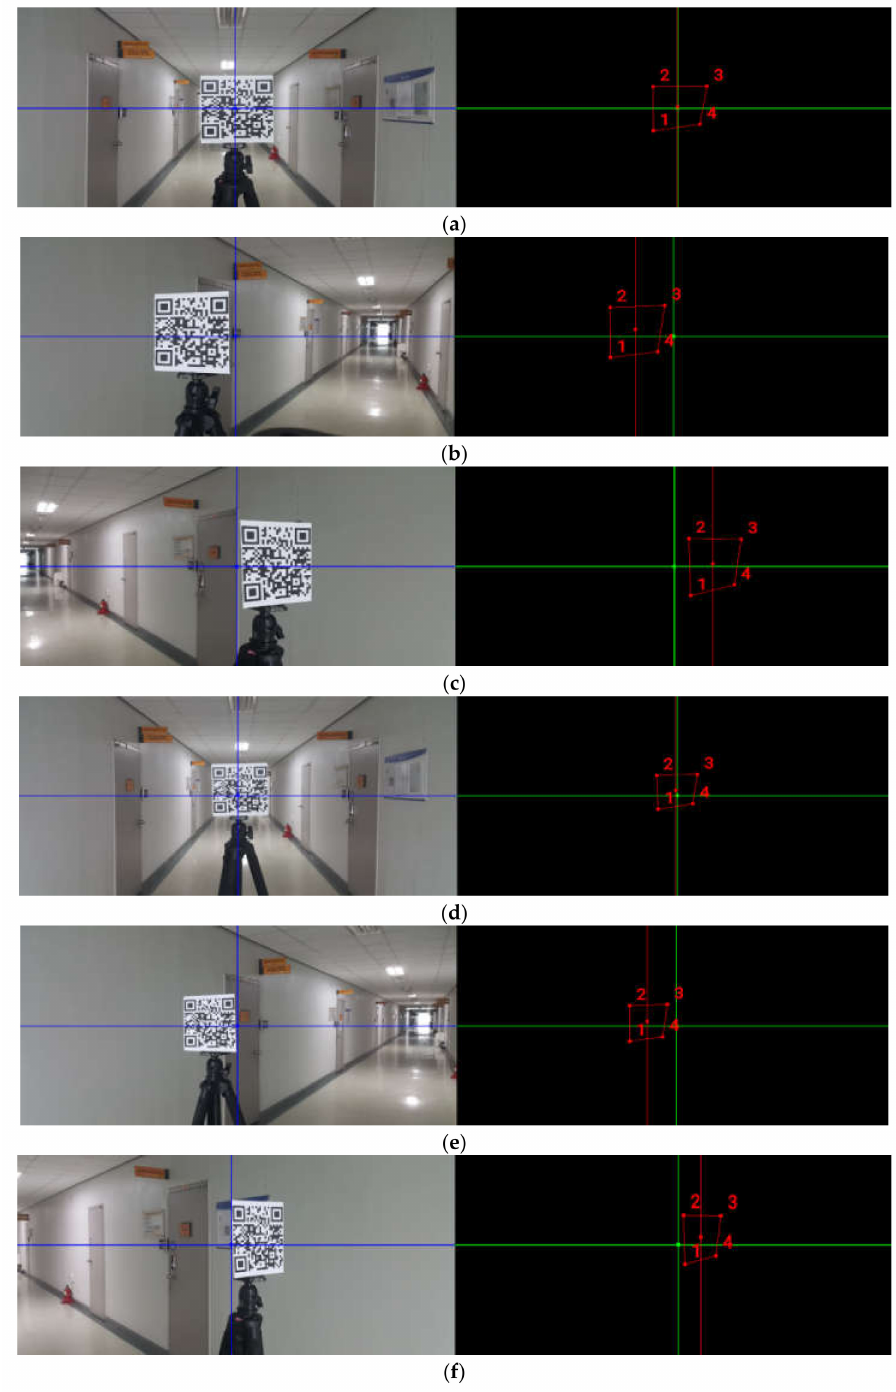
Figure 5. Pictures taken from the ( a ) front, ( b ) left, and ( c ) right at a distance of 1 m. Pictures taken from the ( d ) front, ( e ) left, and ( f ) right at a distance of 2